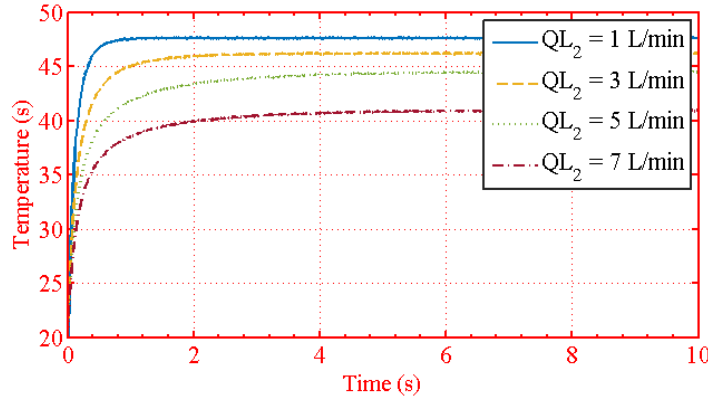
Figure 15. The output temperature in cold fluid with QL 1 = 7 L/min.